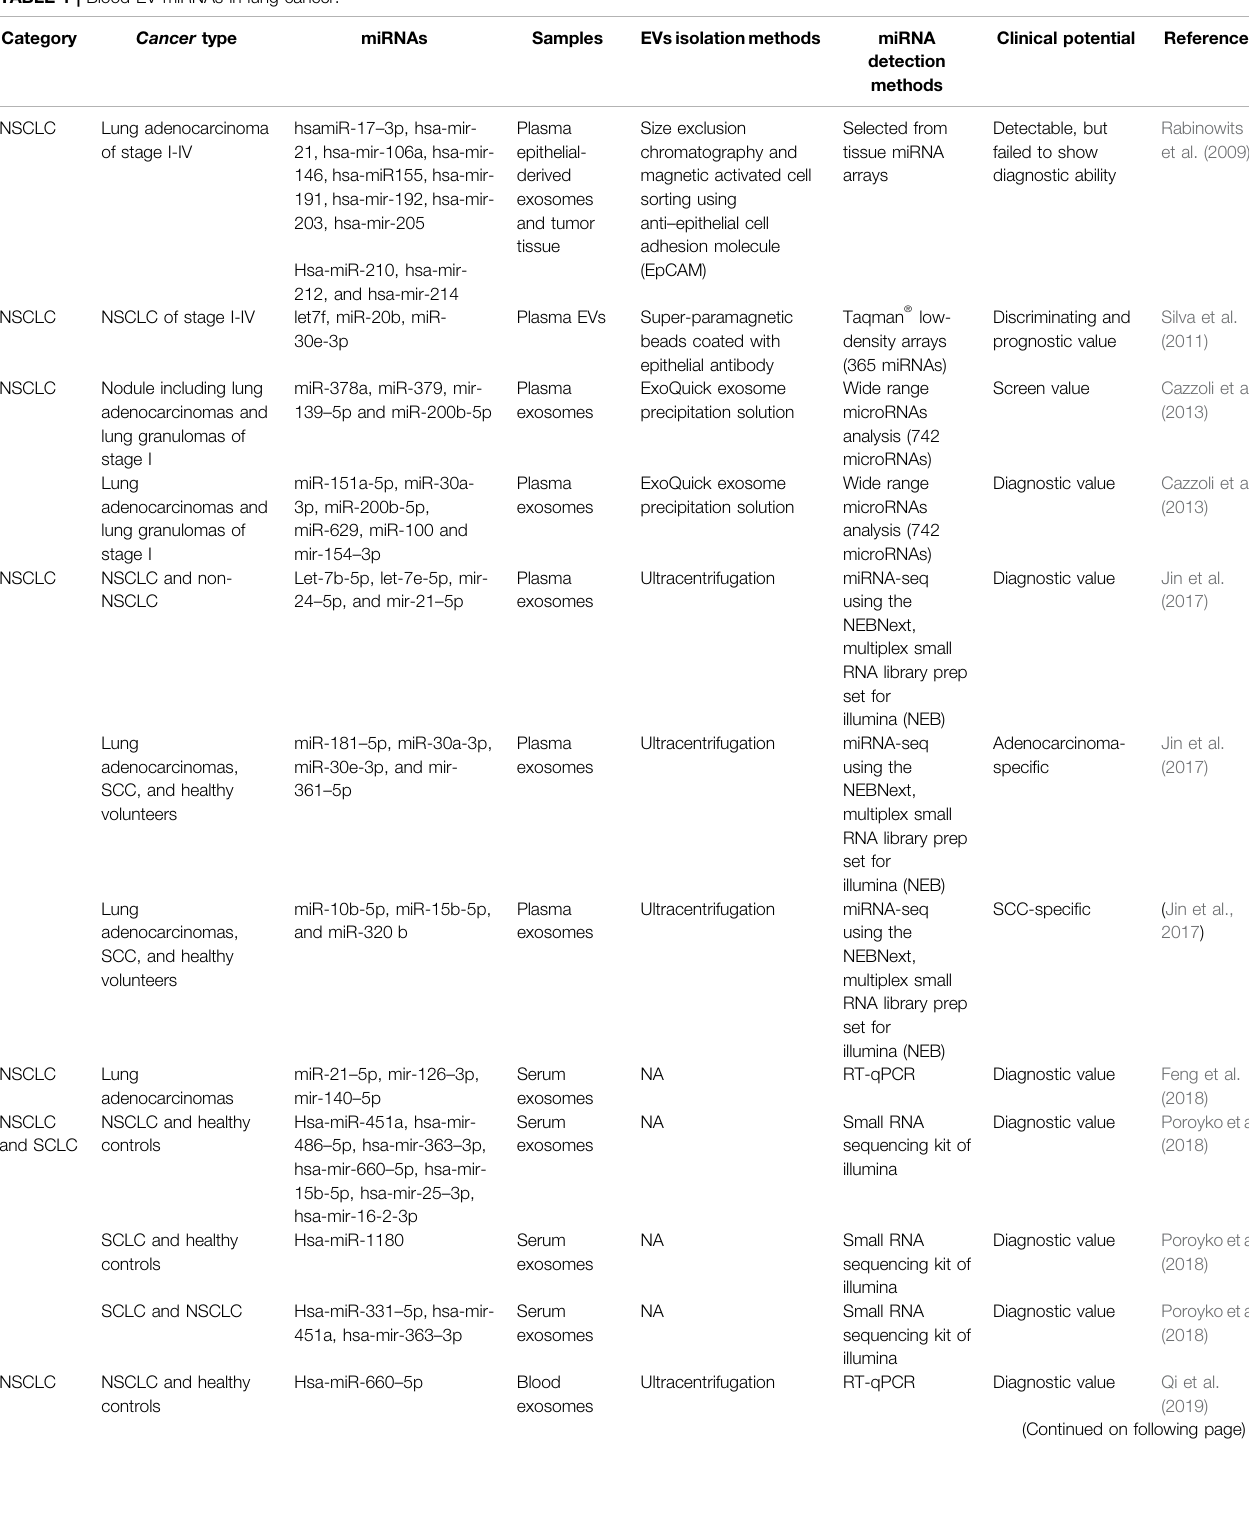
TABLE 1 | Blood EV-miRNAs in lung